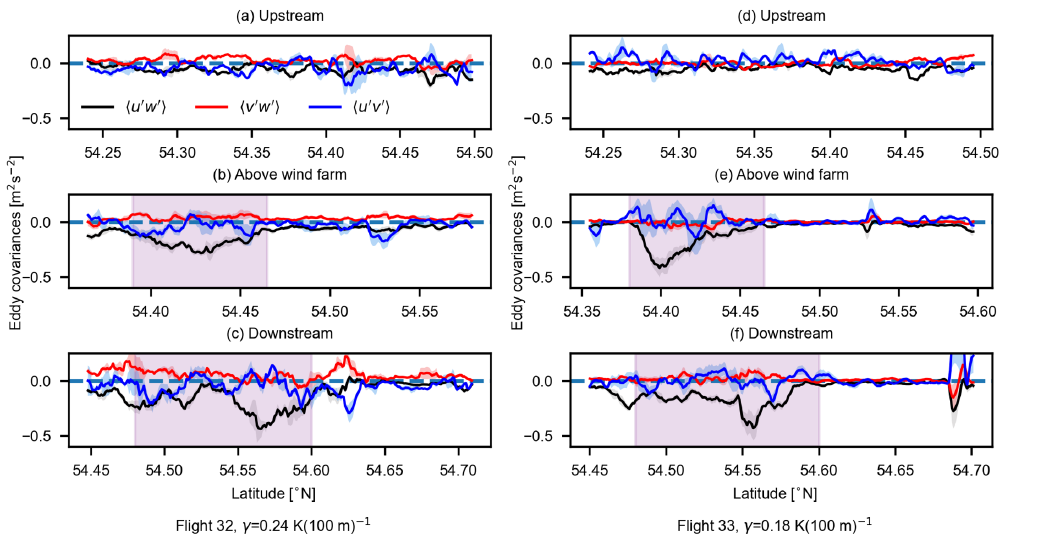
Figure 9. The variation in (cid:104) u (cid:48) w (cid:48) (cid:105) , (cid:104) v (cid:48) w (cid:48) (cid:105) , and (cid:104) u (cid:48) v (cid:48) (cid:105) measured upstream, above, and downstream of the wind farm for flight 32 and flight 33 (weak thermal stratification). The black, red, and blue shaded areas represent the standard error of mean (SEM) due to averaging of data from multiple flight legs. The pink shaded areas on the abscissa represent wind farm boundary in panels (b) and (e) , and the wind farm’s wake projection in the downstream direction in panels (c) and (f) .